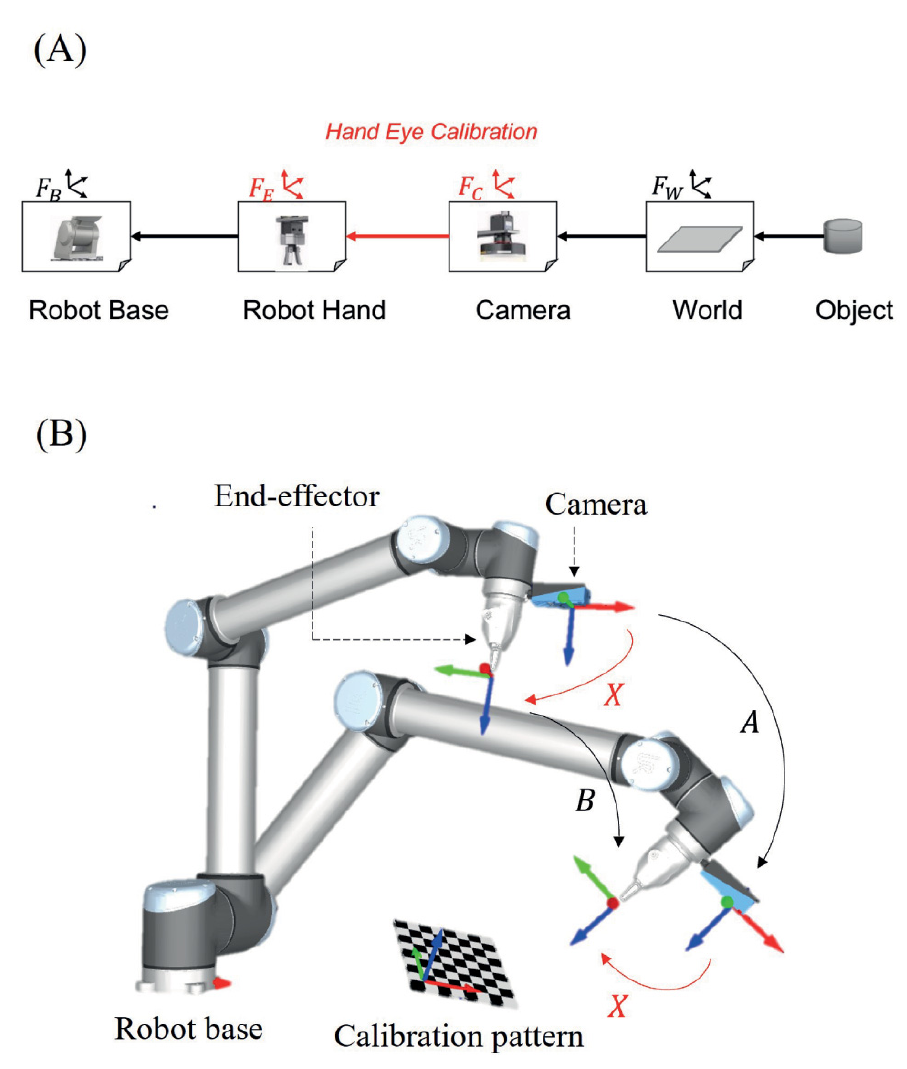
Fig 1. Component frames for vision-guided robot. (A) Frame relationships. (B) Hand-eye setup.